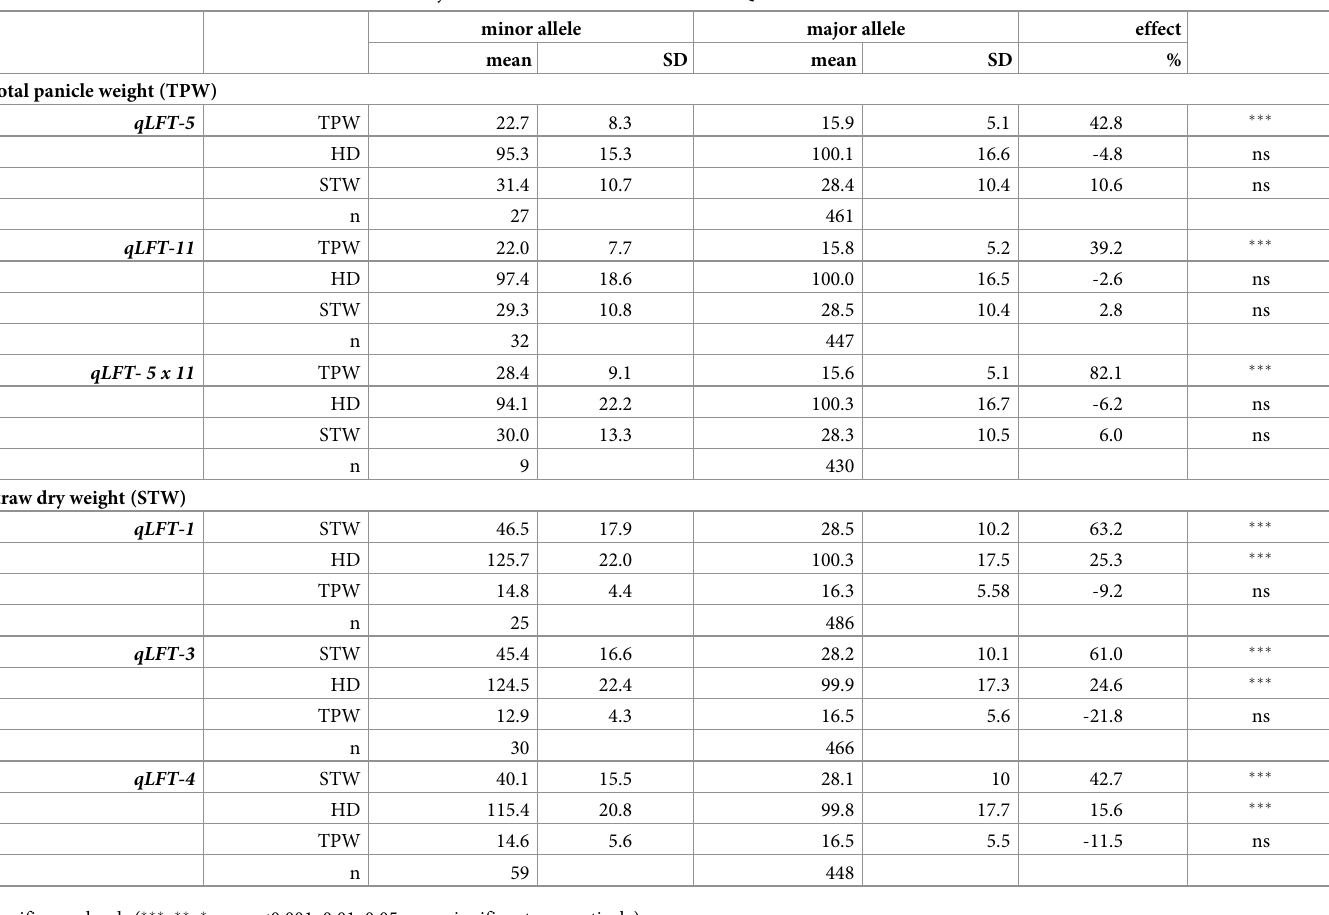
Table 2. Distribution and interaction of minor and major alleles across the main identified QTLs. minor allele major